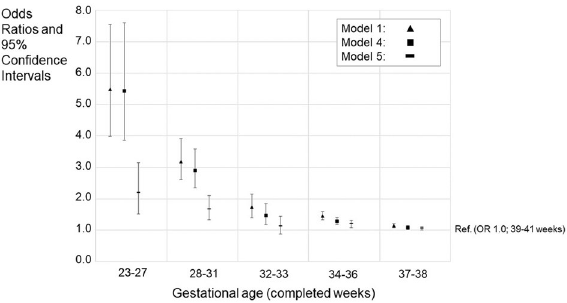
Figure 2. Odds ratios (ORs) and 95% confidence intervals (CIs) for special education in compulsory education according to gestational age category. The figure shows models 1, 4, and 5. Models 2 and 3 are available in the Supplementary Table 3. GA category 39–41 weeks is the reference group (OR = 1.0). Model 1; Unadjusted model, Model 4; Adjusted for the sex, birth year, maternal and paternal ages, maternal and paternal highest attained